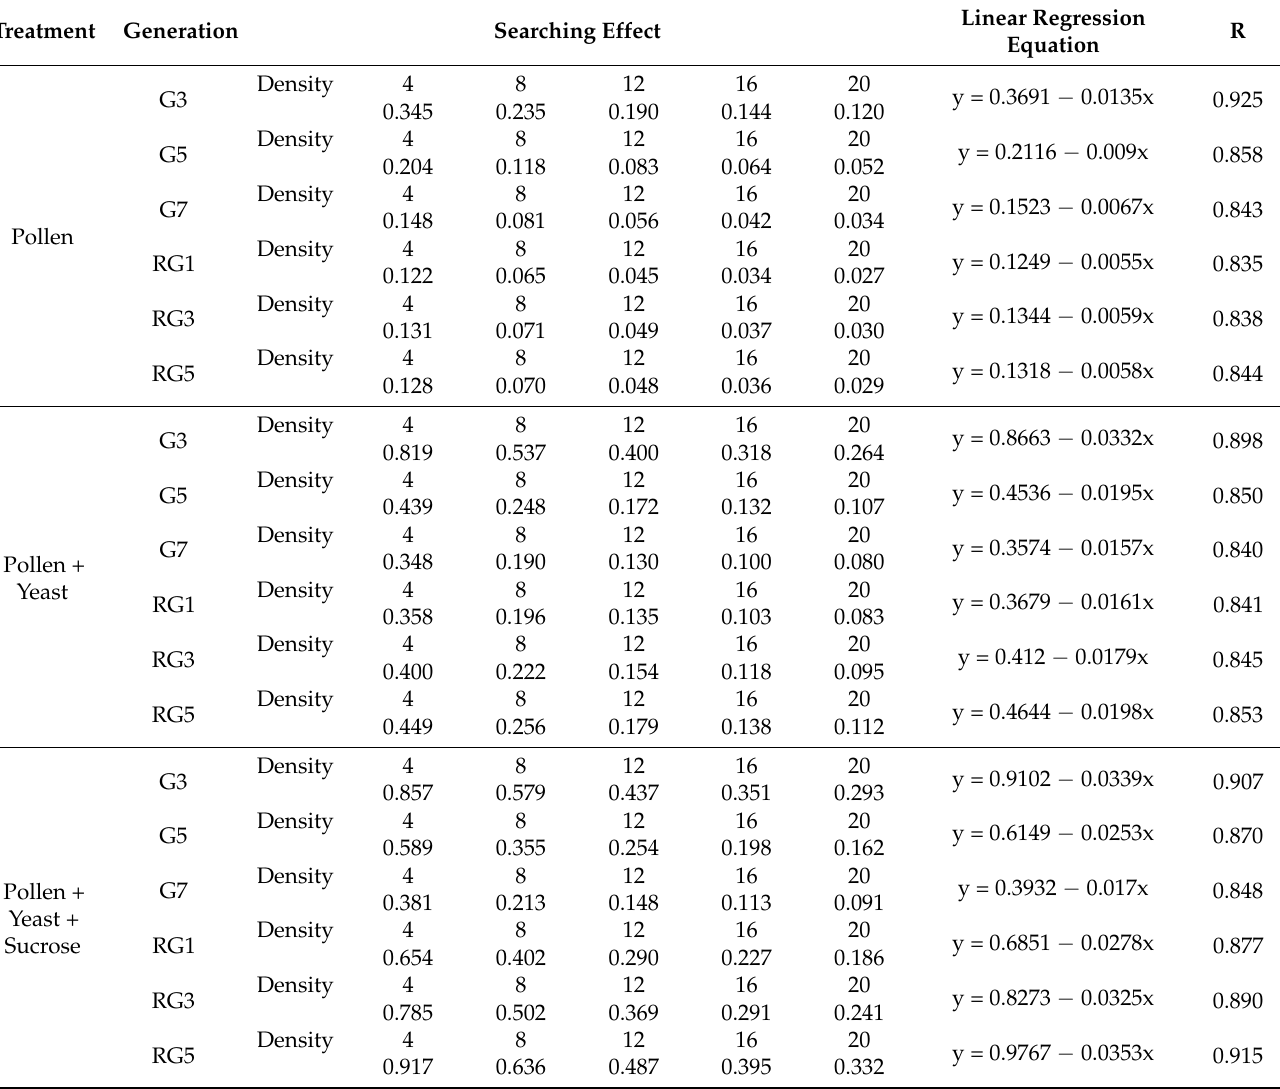
Table 5. The search rate of Amblyseius orientalis individuals in the different treatment